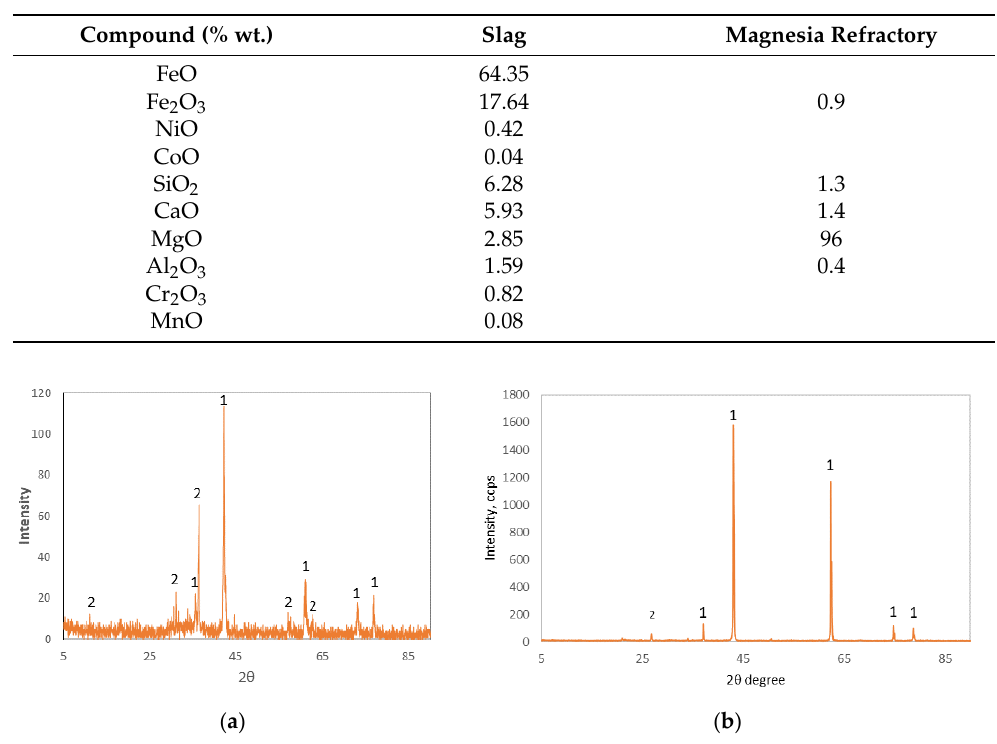
Table 2. Chemical analysis of slag and refractory samples.